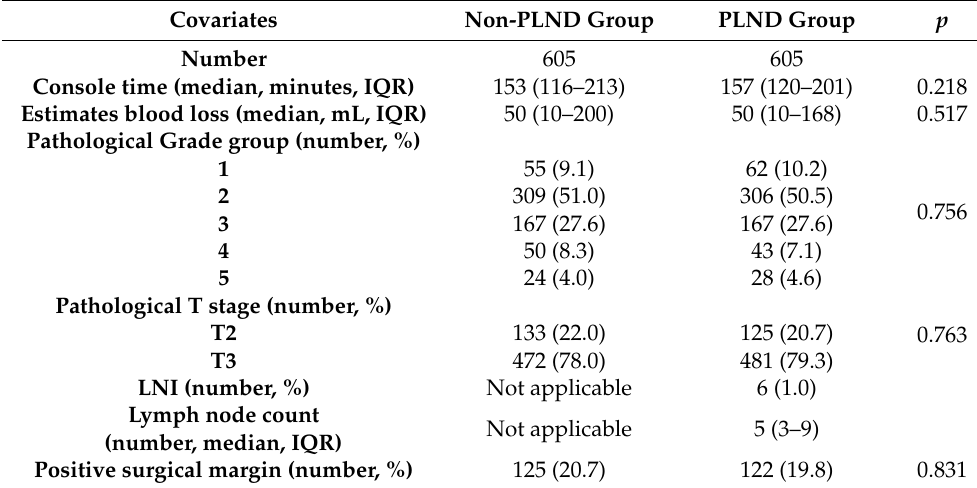
Table 2. Surgical and pathological outcomes.